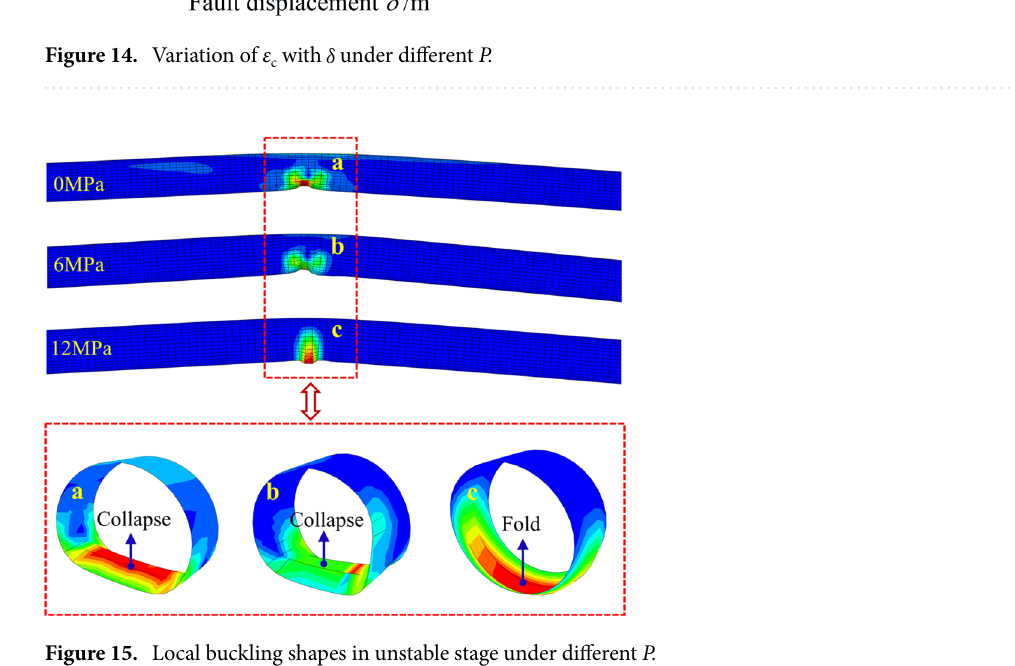
Figure 15. Local buckling shapes in unstable stage under different P.